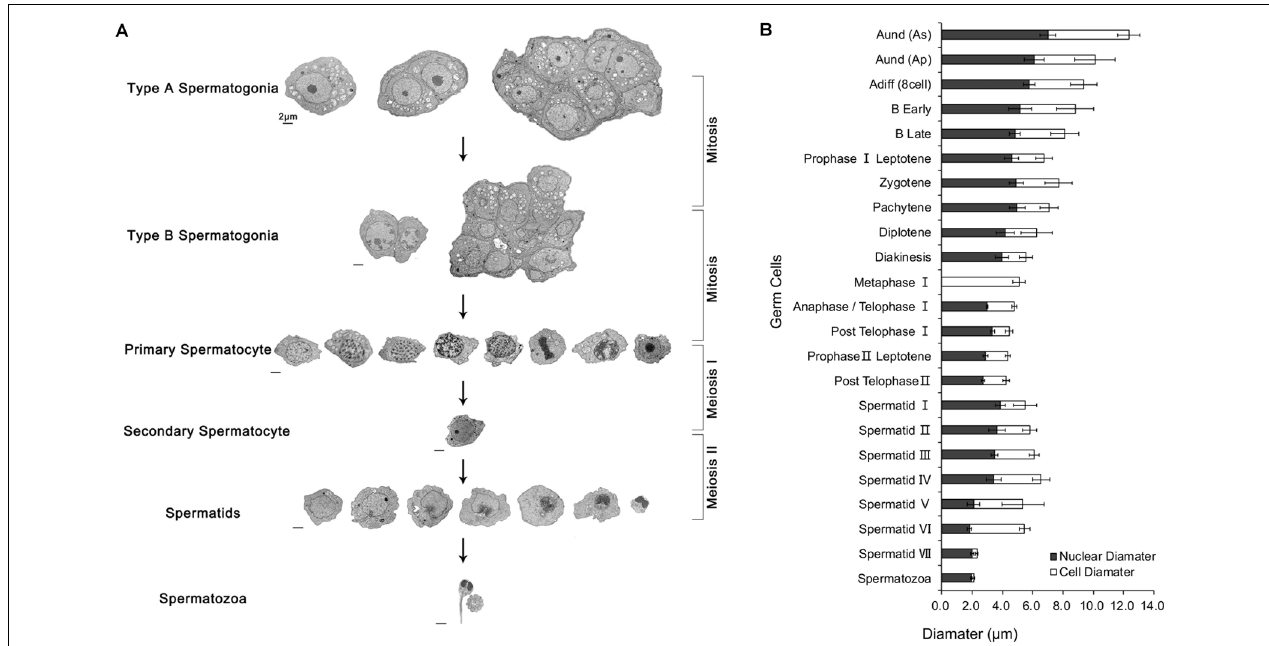
FIGURE 4 | Process of spermatogenesis and changes in cell / nuclear diameter. (A) The cytological process of spermatogenesis. (B) The changes in cell and nuclear diameters during spermatogenesis. Scale bar 2 µ m. n = 6.